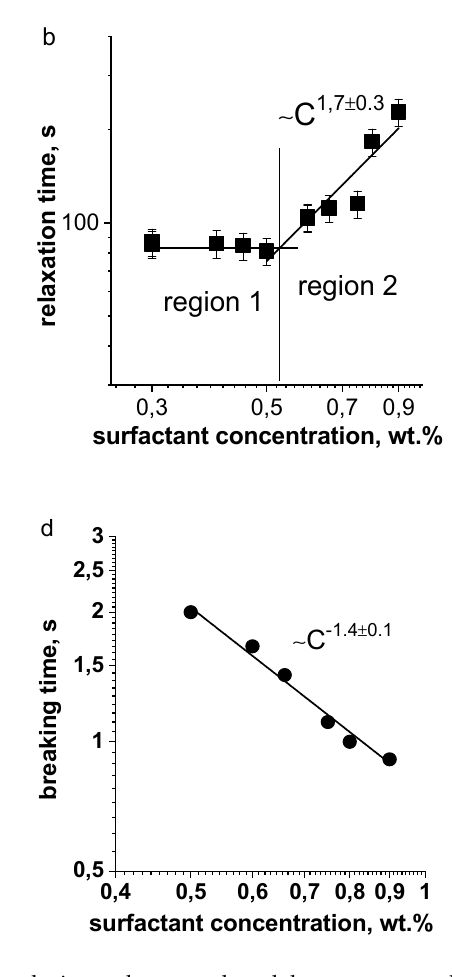
Figure 7. Concentration dependencies of ( a ) mesh size and contour length between entanglements, ( b ) relaxation time obtained from crossover point of G (cid:48) and G (cid:48)(cid:48) moduli, ( c ) the average contour length estimated from moduli ratio, and ( d ) breaking time estimated from loss modulus minimum in EHAC solutions in 1.5 wt.% KCl.